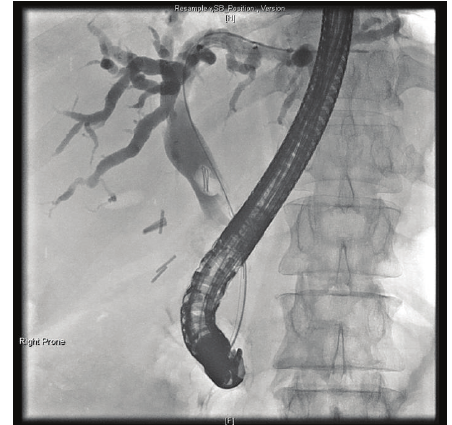
Figure 2: Images obtained at ERCP demonstrating intra- and extrahepatic ductal dilatation secondary to an occluding stone in the distalCBD,passingthroughthepancreatichead,formedaroundtwo migrated surgical